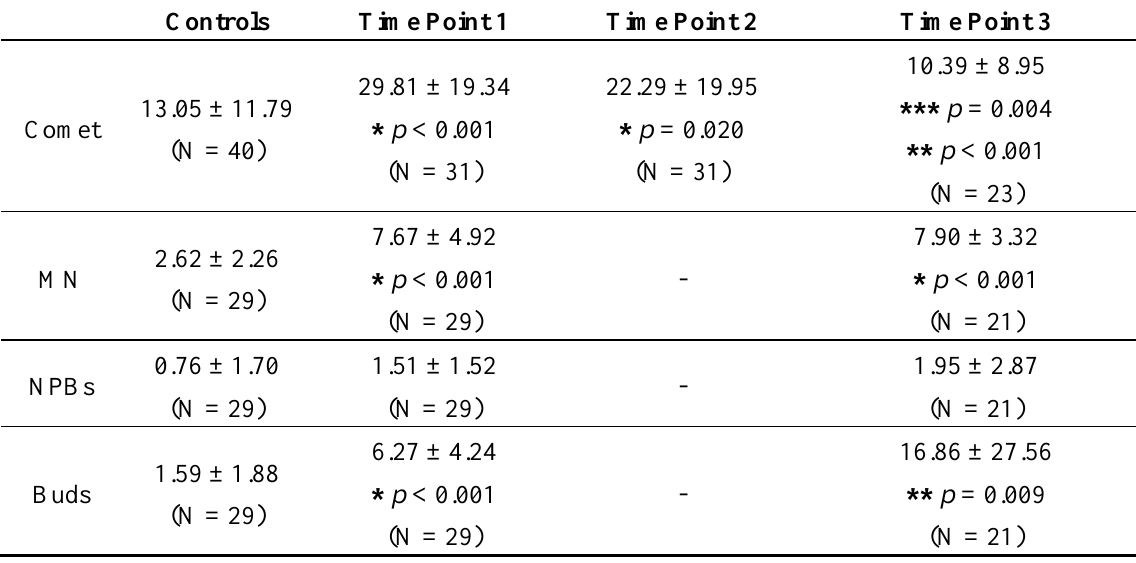
Table 2. Frequency of micronuclei (MN), nucleoplasmic bridges (NPBs) and nuclear buds (NBUDs) and DNA damage scores (comet assay) in samples collected at admission (Time Point 1), 48 h later (Time Point 2) and at the end of treatment (Time Point